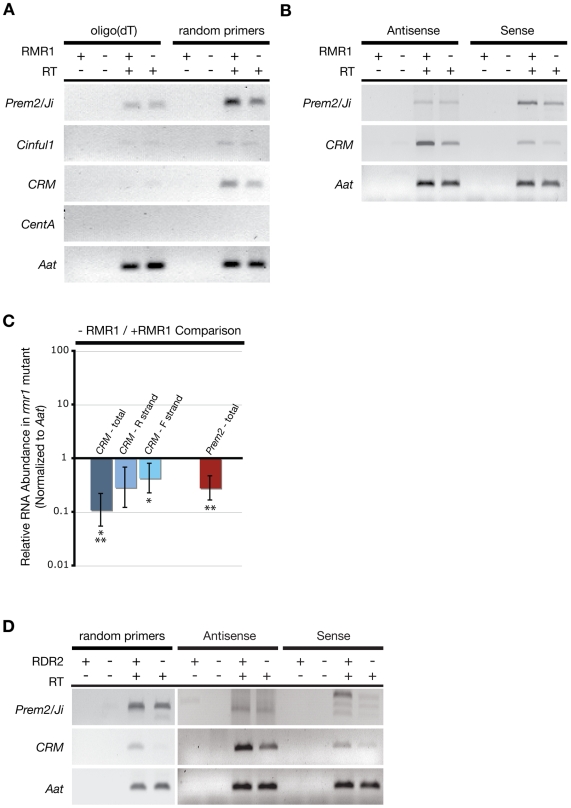
RT–PCR and qRT–PCR measurements of LTR transcripts in RdDM mutants.(A) Representative gel images of RT–PCR products for LTRs and the Aat control from both oligo(dT)-primed and random hexamer-primed cDNA for rmr1 mutants (−) and non-mutants (+). (B) Expected size products of strand-specific RT–PCR. (C) qRT–PCR results comparing changes in abundance of LTR transcripts in rmr1 mutants relative to non-mutants (+/− 2 s.e.m.). “*” and “**” denote significantly different paired results by two-sample z-test (p<0.05). (D) Representative RT–PCR products from random-primed cDNA, and strand-specific cDNA in rdr2 (mop1-1) mutants (−) and non-mutant siblings (+).